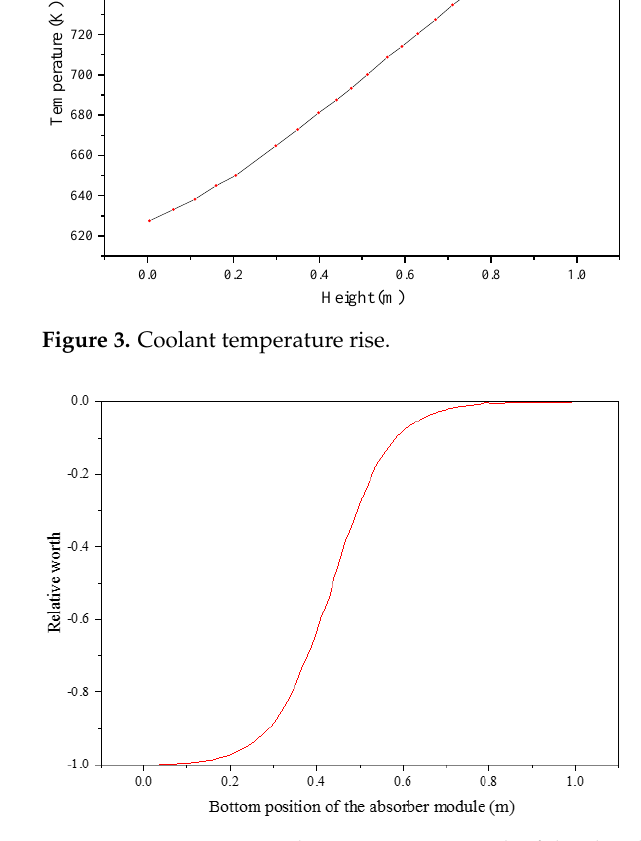
Figure 4. Position-wise relative reactivity worth of the absorber module. Table 1. Kinetic parameters of the large-size oxide SFR ABR.